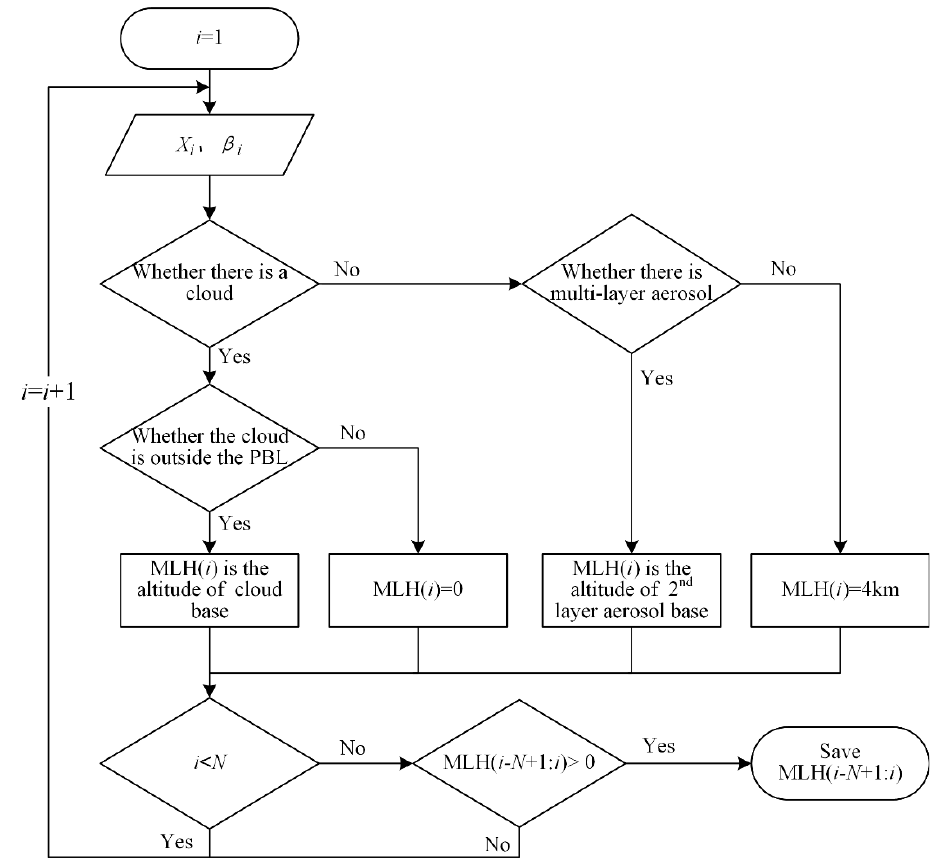
Figure 2. Major steps for initializing the maximum limited height (MLH) under elevated aerosols and clouds situations.